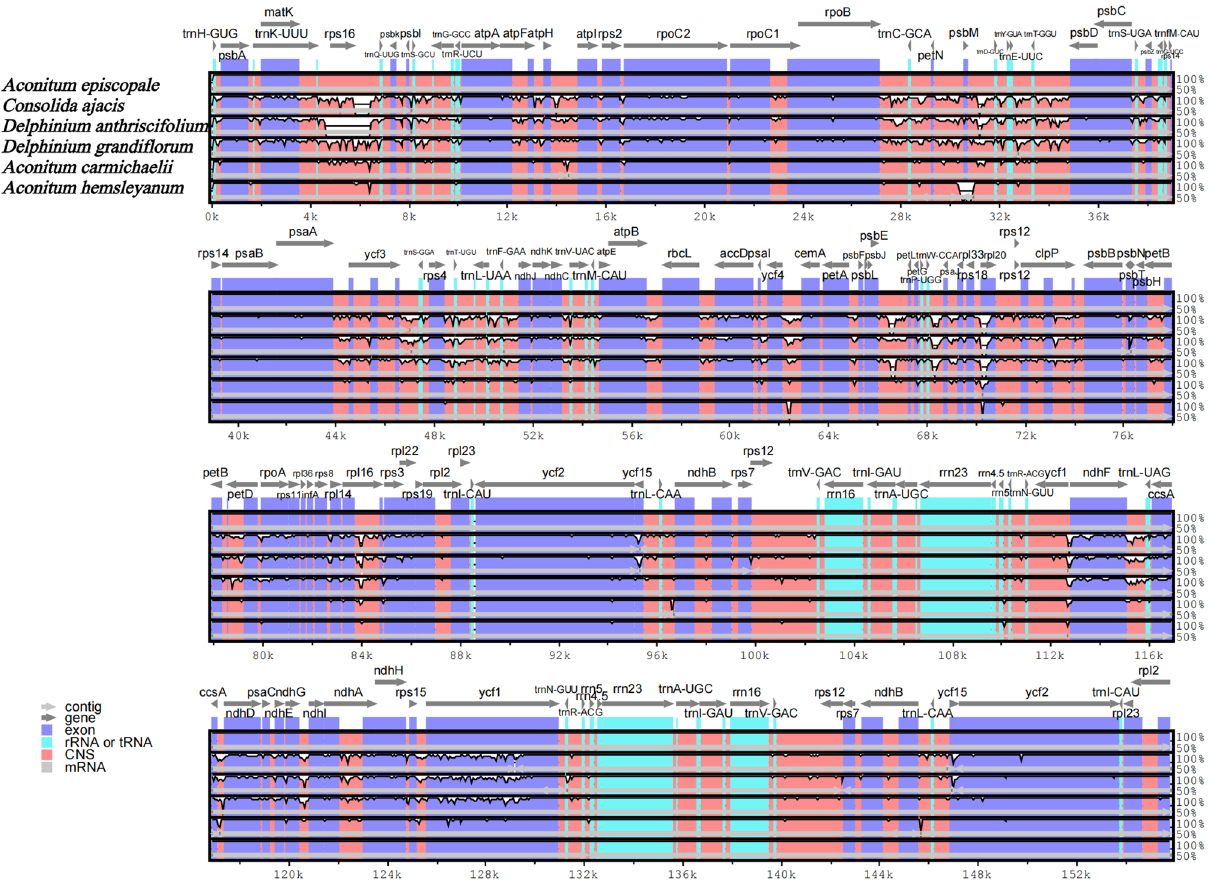
Figure 7. Comparison of the chloroplast genome sequences of A. episcopale , A. hemsleyanum , A. carmichaelii , C. ajacis , D. grandiflorum , and D. anthriscifolium generated with mVISTA. Grey arrows indicate the position and direction of each gene. Red and blue areas indicate the intergenic and genic regions, respectively. The vertical scale indicates the percentage of identity, ranging from 50 to